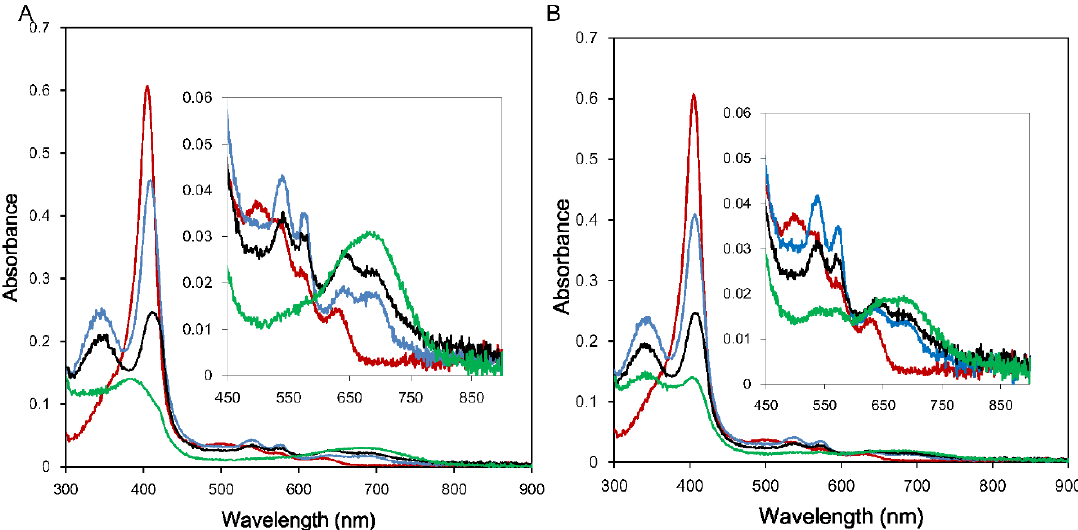
Figure 2. Changes in the absorption spectra of 4.3 µ M heme–rHO-1 during the single turnover reaction in the presence of NADPH–rCPR or NADPH–147CC514. ( A ) Reaction with 0.04 µ M rCPR. The spectra were recorded before (red) and 30 sec (cyan), 3.5 min (black), and 30 min (green) after NADPH addition. ( B ) Reaction with 0.1 µ M 147CC514. The spectra were recorded before (red) and 3 min (cyan), 10 min (black), and 40 min (green) after NADPH addition. Magnified views of the visible region are in shown in the insets.